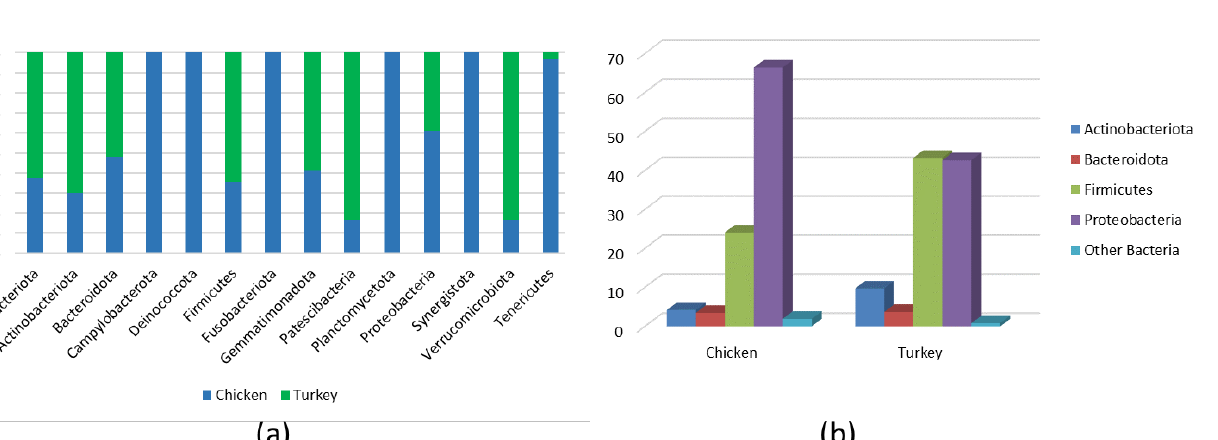
Figure 2. Relative abundance of the 10 most prevalent families among the URT bacteria in ( a ) chick- ens and ( b ) turkeys.